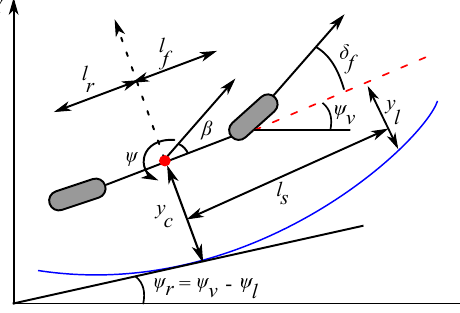
Figure 1. The nonlinear bicycle model of